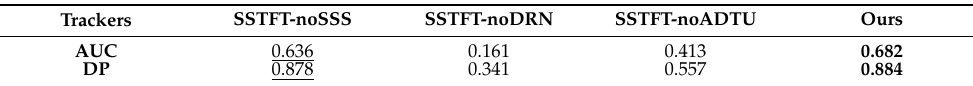
Table 9. Ablation experiment on IMEC16.